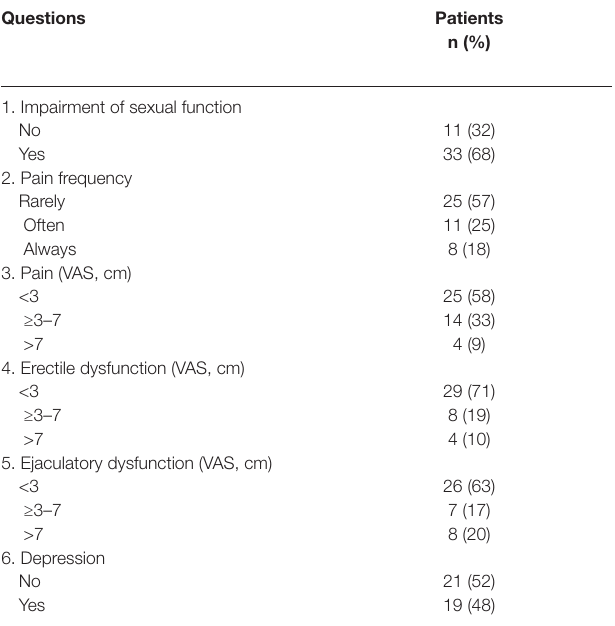
Table 3 | SexIHQ results (n = 44).